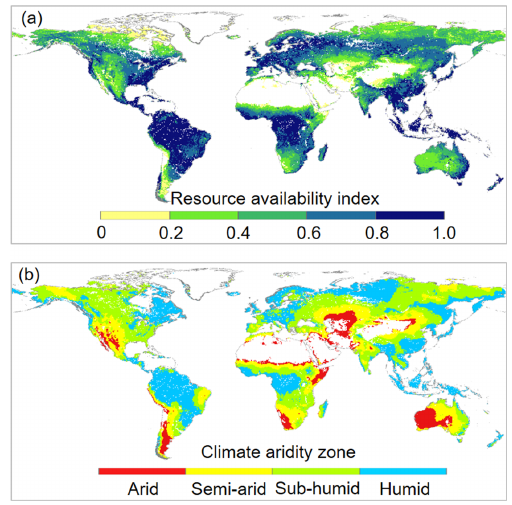
Figure 2. Spatial distributions of (a) resource availability index cat- egories and (b) climate aridity zones over global vegetated lands for 1982–2010. For the land surface, blank areas are non-vegetated re- gions. Respectively, there are 2536, 8194, 10316, 12930, and 9093 0 . 5 ◦ × 0 . 5 ◦ resolution grid cells in the 0.0–0.2, 0.2–0.4, 0.4–0.6, 0.6–0.8, and 0.8–1.0 resource availability index